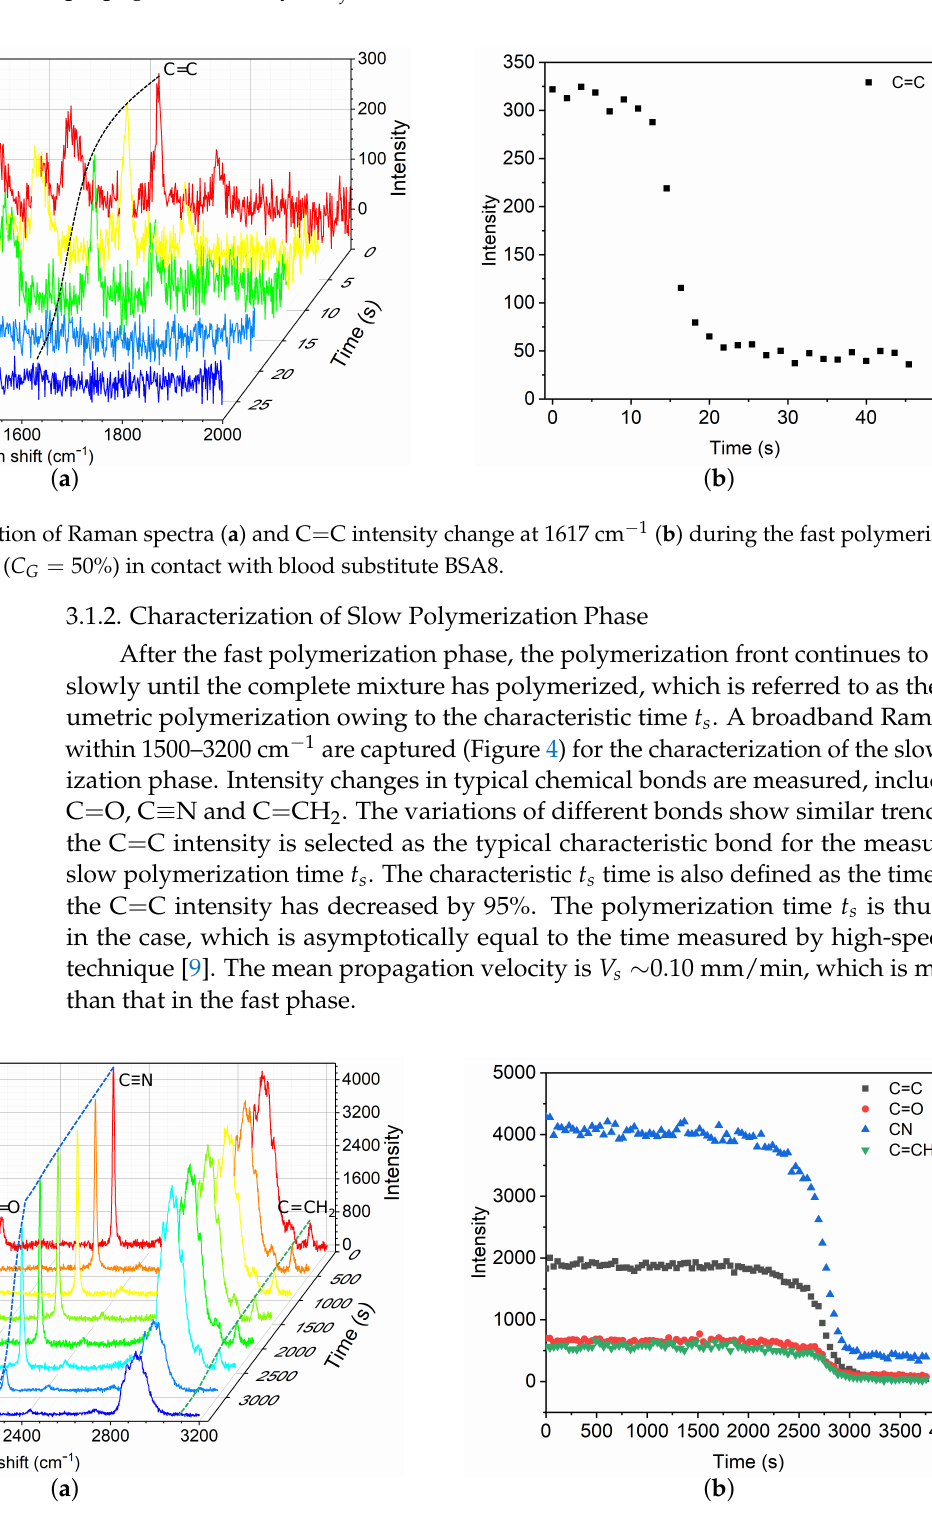
Figure 4. Time evolution of Raman spectra ( a ) and intensity change in chemical bonds ( b ) during the slow polymerization phase of GO mixture in contact with blood substitute BSA8. The Raman shifts of C=C, C=O, C ≡ N and C=CH 2 are 1617 cm − 1 , 1731 cm − 1 , 2239 cm − 1 and 3128 cm − 1 ,